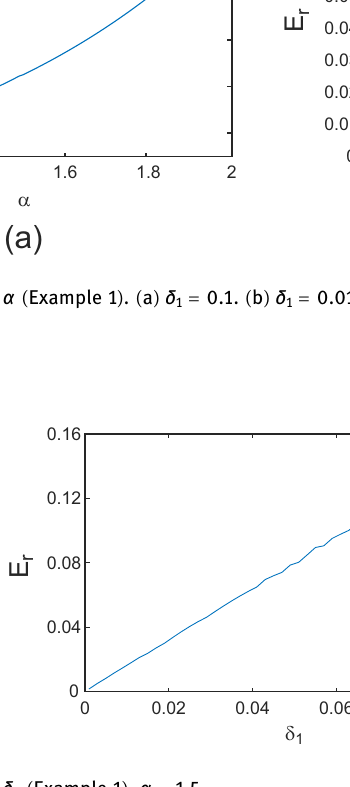
Figure 3: The variation of E r with δ 1 ( Example 1 ) . α 1.5 = .